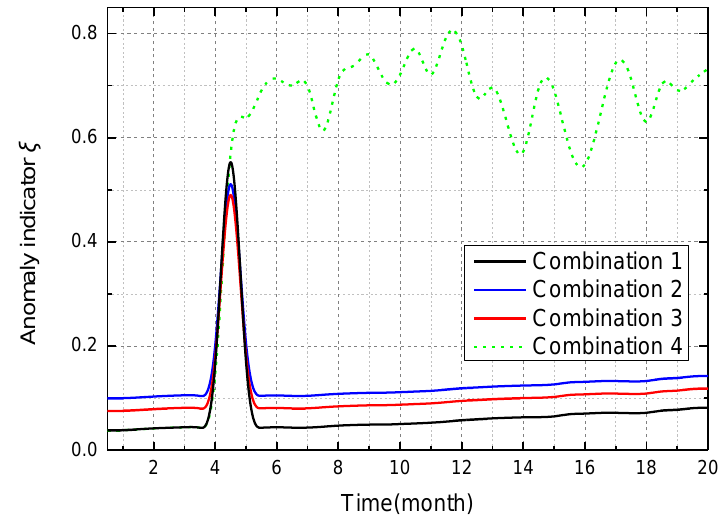
Figure 13. Anomaly indicator ξ of node 284 5 using methods with different combinations over a long-term span.